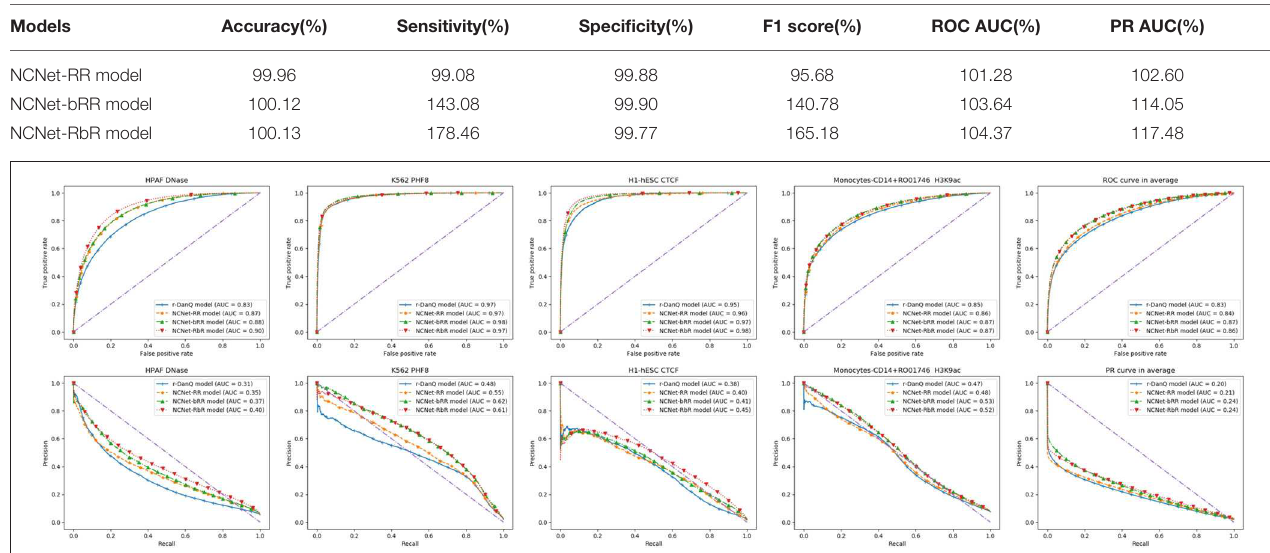
TABLE 1 | Relative performance of NCNet models compared to r-DanQ model.